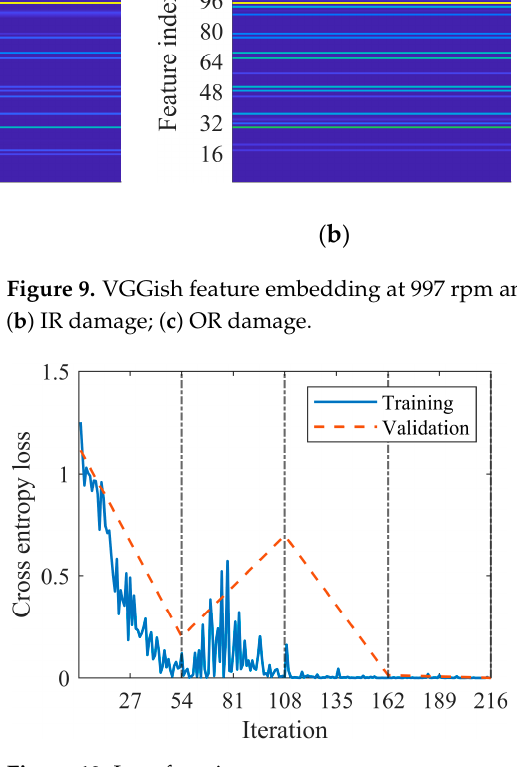
Figure 10. Loss functions. Table 7. Diagnosis accuracies.